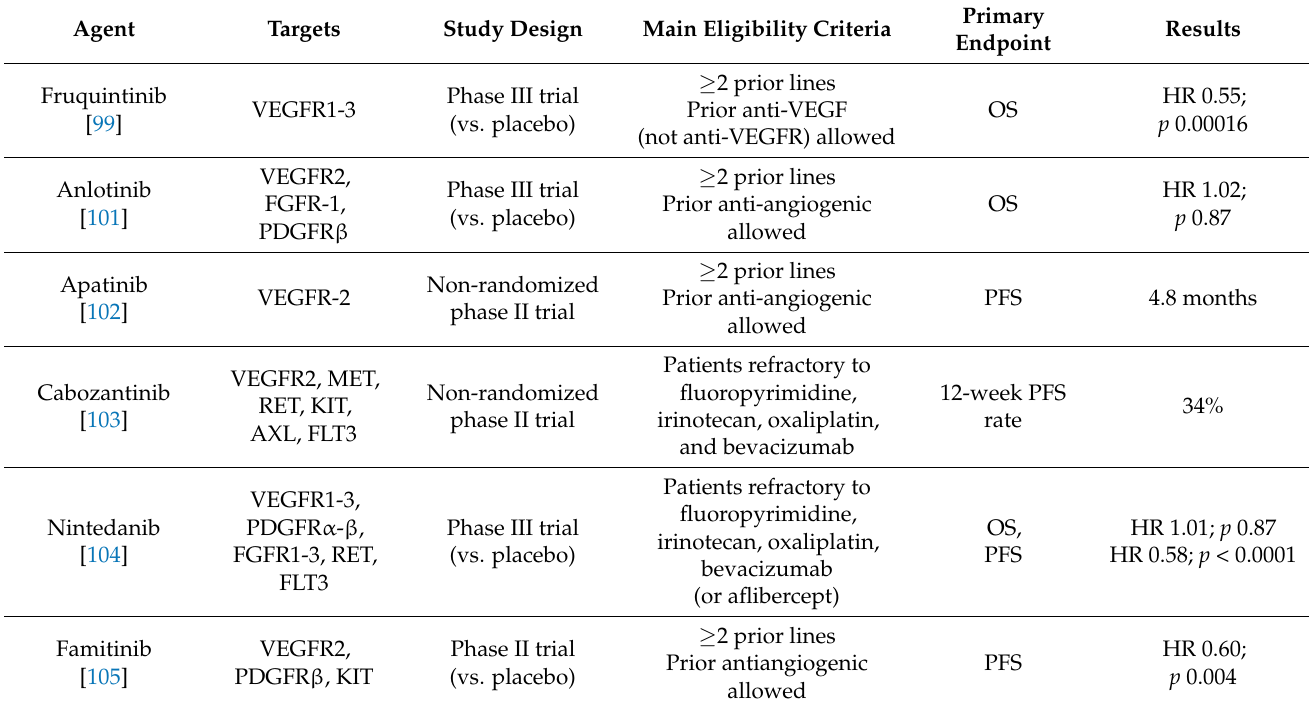
Table 3. Main anti-angiogenic MKIs tested as single agents in chemorefractory mCRC. Agent